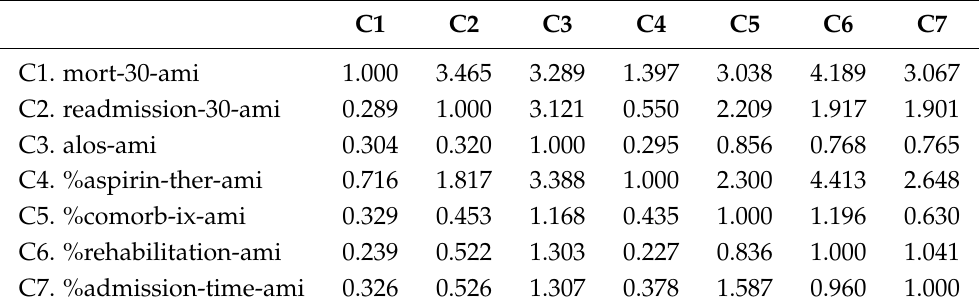
(Table 4). All individual pairwise comparison matrices, as well as the aggregated matrix, were consistent. Table 4. Group pairwise comparison matrix for the acute myocardial infarction (AMI).